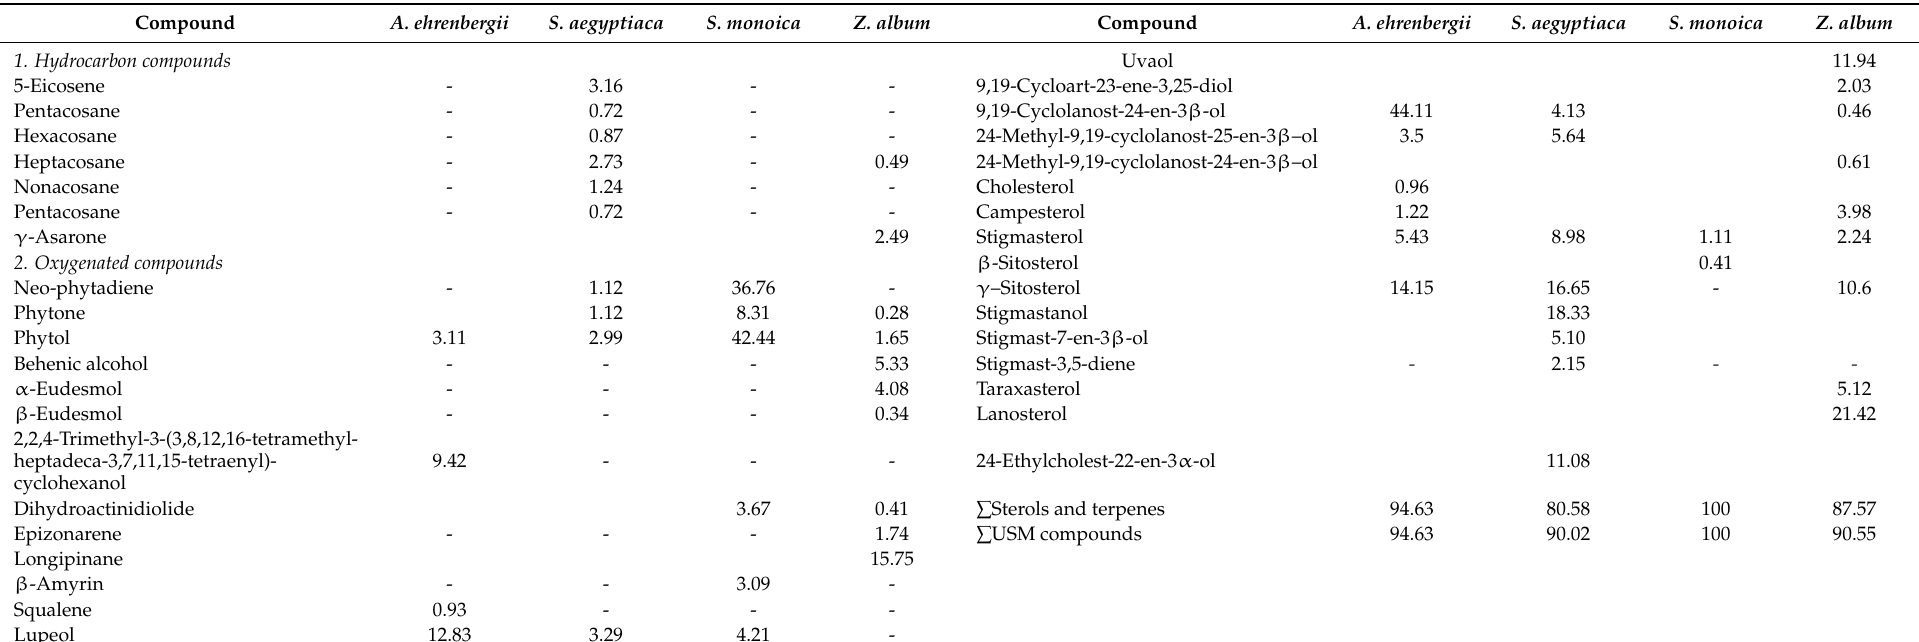
Table 5. Unsaponifiable matters (USM, relative %; n = 2) of the investigated Red Sea